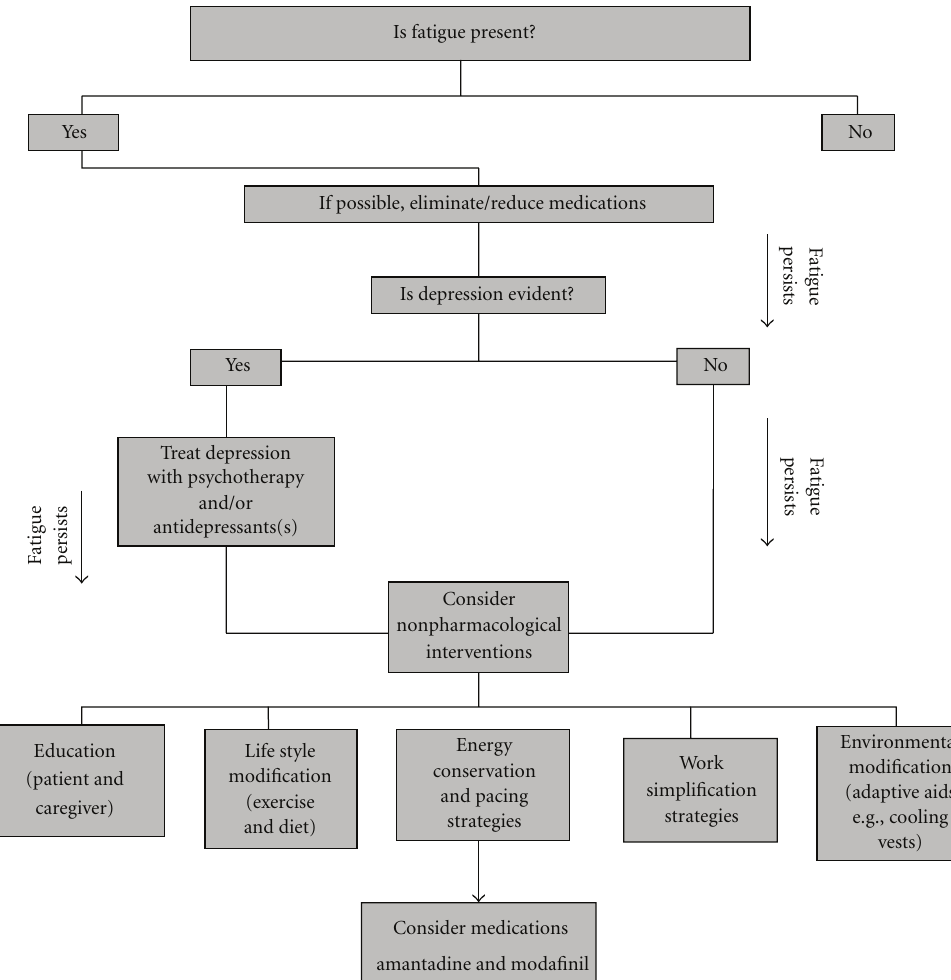
Figure 3: Clinical decision making flow chart for treating fatigue in MS. (Adapted from: MacAllister and Krupp [48].)